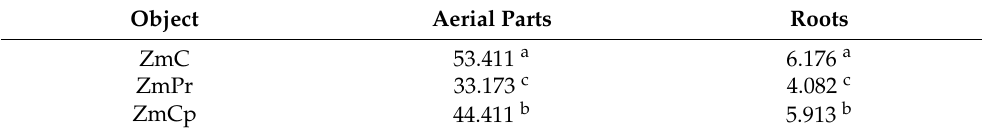
Table 1. Yield of aerial parts and roots of Zea mays , g d.m. pot − 1 . Object Aerial Parts Roots